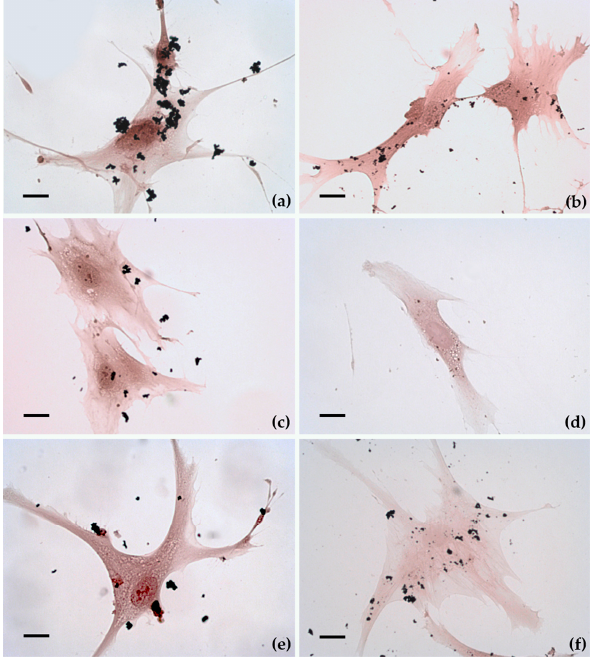
Figure 3. Optical microscopy photographs of hASCs exposed for 24 h to micro and nanoparticles and stained with haematoxylin-eosin solution. Micro- and nanoparticles are visible as black corpuscles. FeMPs ( a ), FeNPs ( b ), CoMPs ( c ), CoNPs ( d ), NiMPs ( e ), and NiNPs ( f ). All cells maintain the classical fibroblast-like morphology. Original magnification: 20×. Bar indicates 40 µm.